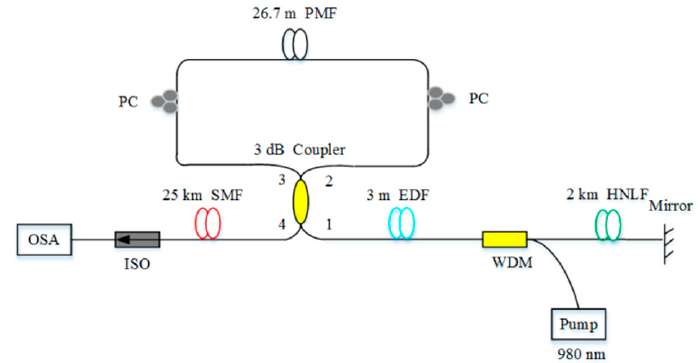
Figure 13. Experimental setup of multi-wavelength erbium-doped RFL. ISO, isolator; HNLF, high nonlinear optical fiber.